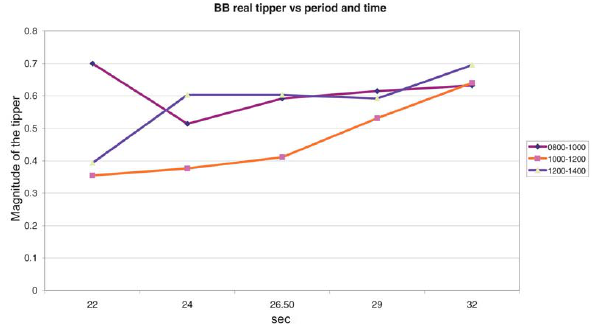
Fig. 11. BBZ real tippers at FLR periods (22, 24, 26.5 s) in 30 min sections, 0800-1400 UT.